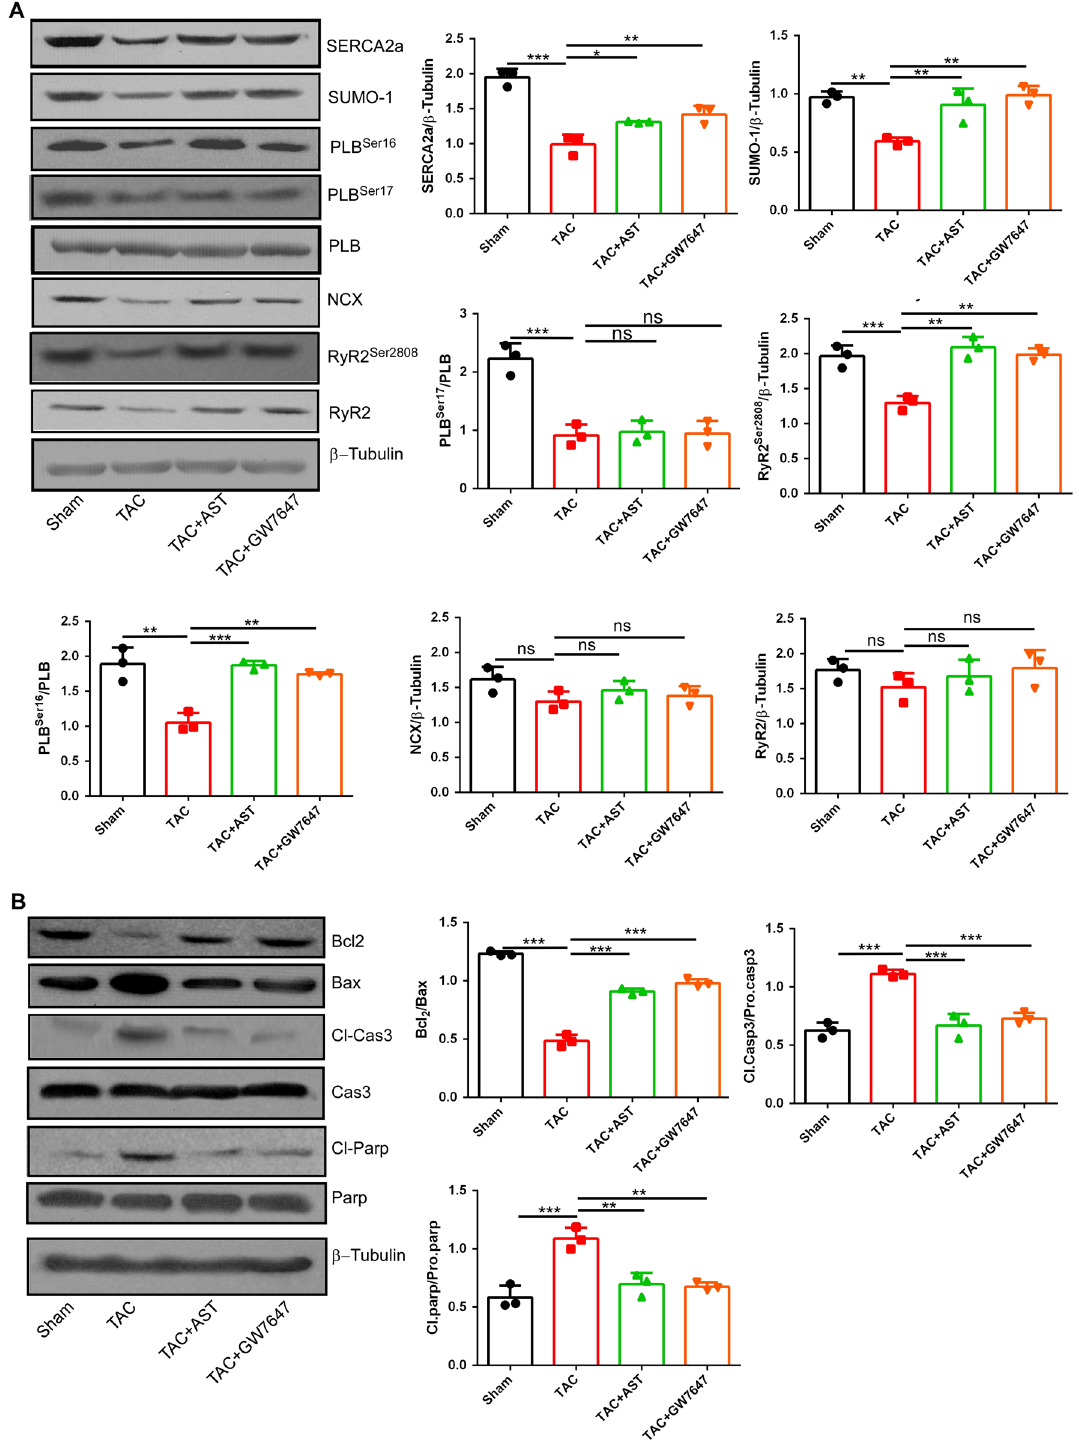
Figure 6. Astragaloside IV treatment enhanced the expression of Ca2 + regulatory proteins in the sarcoplasmic reticulum and inhibited the expression of apoptotic protein. ( A ) Heart tissue fractions were prepared and the collected supernatants containing 50 μ g of protein were subjected to western blot analysis and probed with antibodies against SERCA2a, NCX, SUMO1, RyR2, p-RyR2 Ser2808, p-PLB ser16, p-PLB thr17. The data represent three independent experiments. The original gels images are shown in Supplementary Fig. S3. ( B ) Heart tissues were lysed and the proteins subjected to immunoblotting with antibodies against the apoptosis- related proteins Bcl-2, Bax, cleaved caspase-3, caspase-3, cleaved PARP and PARP. α -Tubulin was used as the marker for the cytosolic fractions. The original gels images used for A are shown in Supplementary Fig. S4. * P < 0.05, ** P < 0.01 and *** P < 0.0001 (n = 5). Data are mean ±